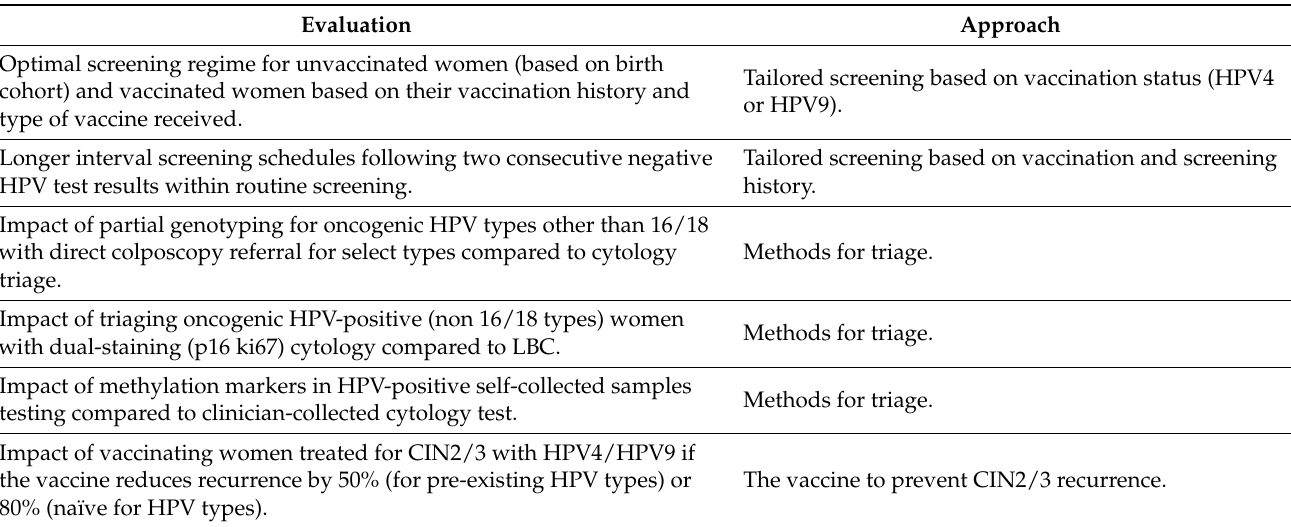
Table 2. Promising ways to enhance secondary cervical cancer prevention according to Australia’s Scientific Advisory Committee (SAC) (Adapted from Ref. [15] (do not require